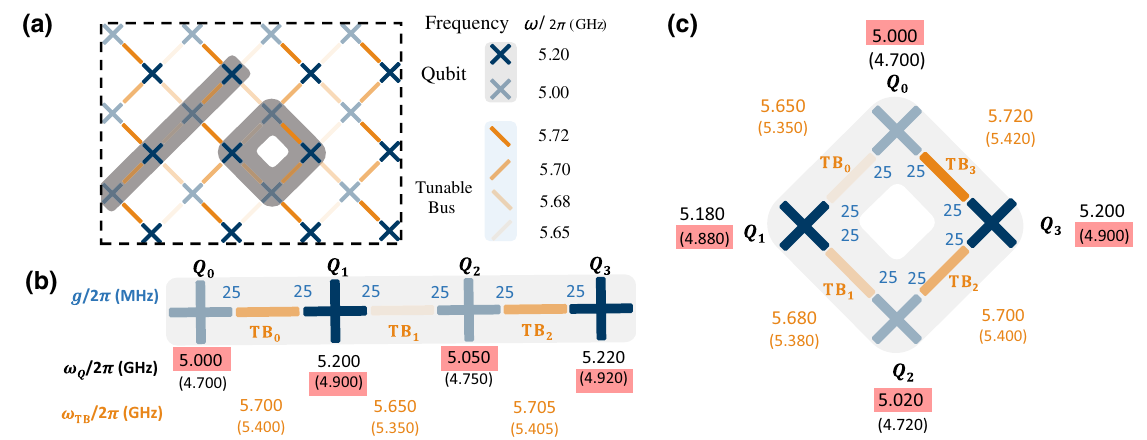
FIG. 5. (a) Layout of a two-dimensional qubit lattice, where cross-shaped vertices (steel blue) denote qubits, and strip-shaped edges (orange) between adjacent qubits represent tunable buses. Qubits in the lattice belong to one of the two frequency bands, i.e., a lower frequency band with typical frequency ω/ 2 π = 5.000 GHz (light steel blue) or a higher frequency band with typical frequency ω/ 2 π = 5.200 GHz (dark steel blue). The typical detuning between nearby qubits is about 200 MHz, and at the idle point, the bus frequency is typically above 500 MHz of the qubits in the higher frequency band. Example of system parameters of four-qubit chain and 2 × 2 four-qubit square shown in the gray shadow of (a) is presented in (b),(c), respectively, e.g., for Q 0 in the four-qubit chain shown in (b), the qubit frequency is ω Q / 2 π = 5.000 GHz, and its anharmonicity is − 300 MHz (i.e., its transitions frequency between